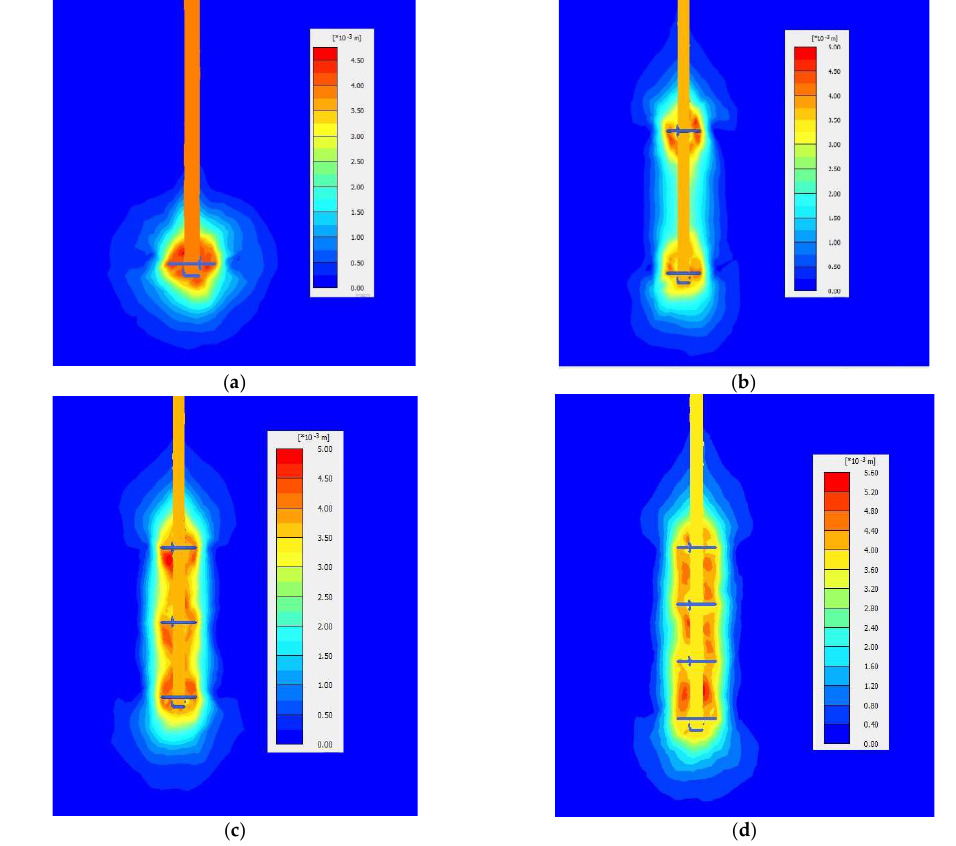
Figure 13. A typical displacement contour of a fully embedded helical pile under uplift load is shown in cross section. ( a ) SHP-1-12; ( b ) SHP-2-8.75; ( c ) SHP-3-8.75; and ( d ) SHP-4-8.75.